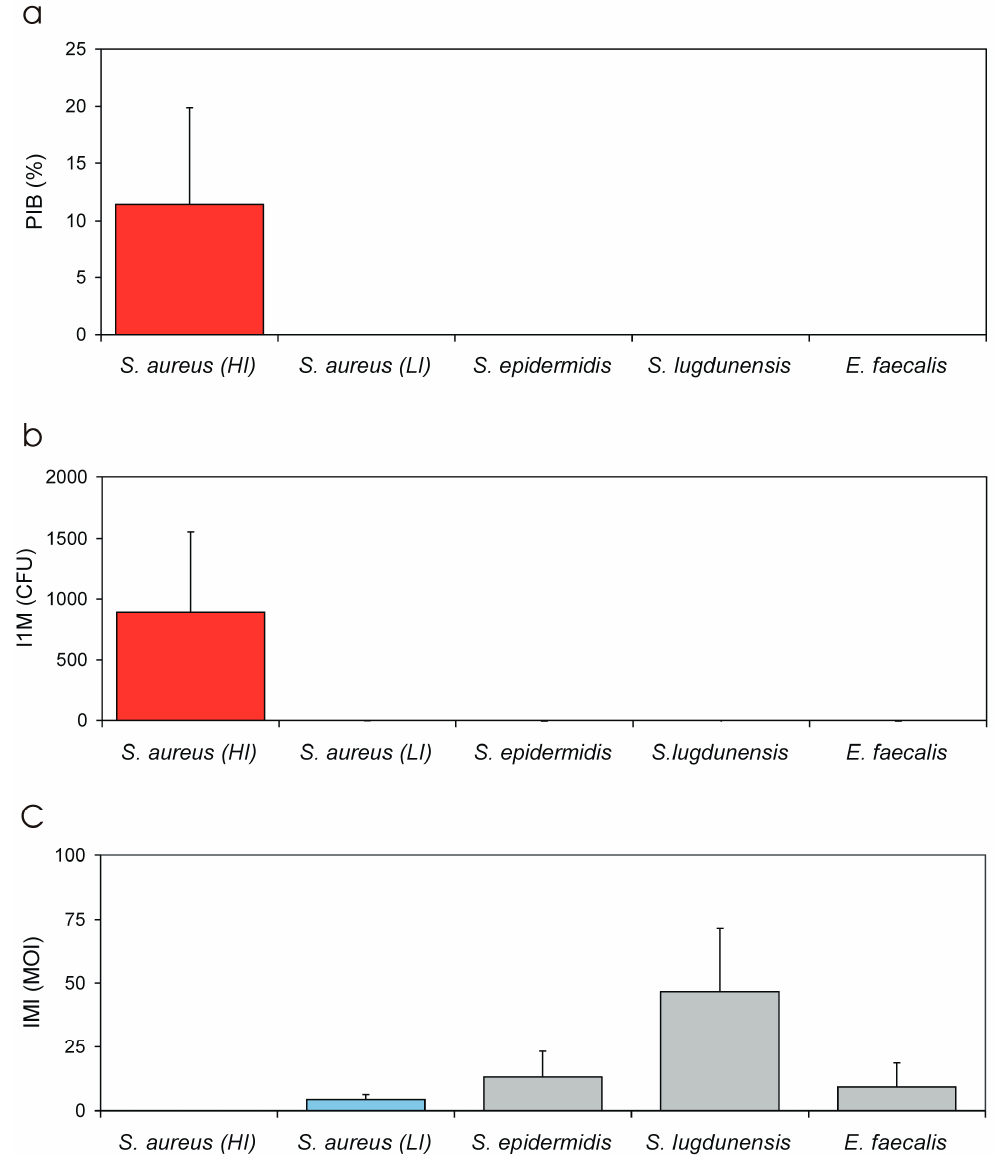
Figure 7. Different invasiveness across all investigated bacterial species expressed in terms of: ( a ) PIB; ( b ) I1M; and ( c ) IMI. Bars represent mean values ± S.D. Bar graphs with PIB and I1M values consistently show the gap between HI S. aureus strains and the LI strains and the strains of all other species. In the case of IMI, the higher is the internalization minimal inoculum. The lower is the invasiveness. Thus, IMI could also be interpreted as a measure of the resistance to phagocytosis. Here, even when compared to other incompetent species, S. lugdunensis exhibits the highest IMI and, therefore, emerges as the species with the lowest uptake by osteoblasts.